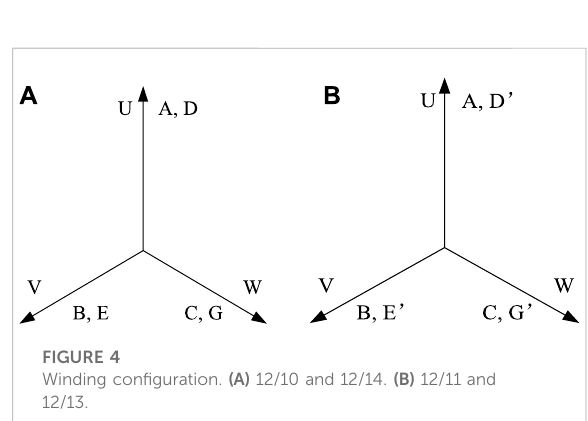
FIGURE 3 Schematic coil fl ux with the increase in inner-layer ferrite PMs.